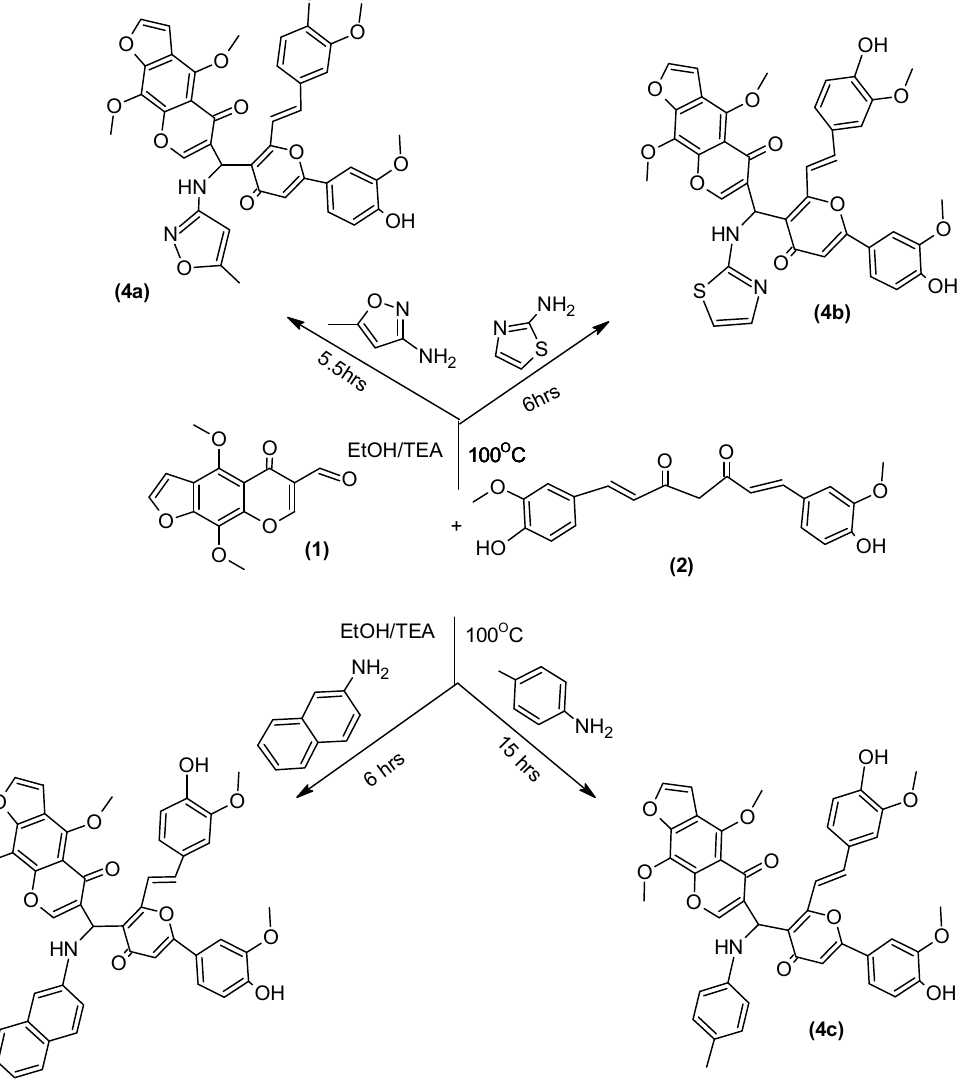
Fig 2 : synthesis of compounds (4a-d) Scheme 2. Synthesis of compound 4a – d